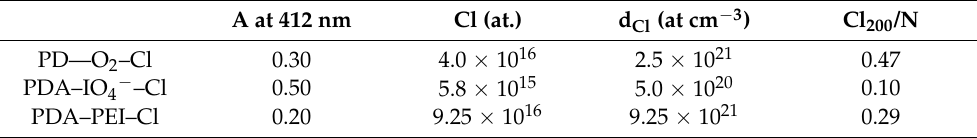
Table 3. TNB solution absorption (A) at 412 nm after 24 h of immersion of various samples, the number of chlorine atoms, density (Equation (3) of chloramine in PDA–O 2 , PDA–IO 4 − and PDA– PEI coatings estimated by TNB dosage, and the Cl 200 /N atomic ratio considering a N density of 5.3 × 10 21 at cm − 3 . A at 412